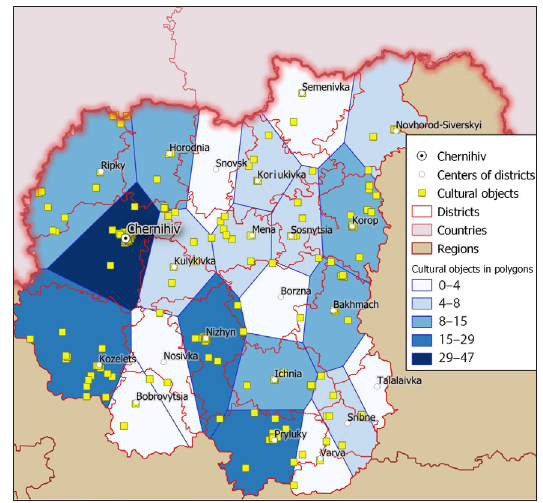
Figure 6. A Voronoi diagram of historical and cultural objects of Chernihiv region with loci around the centers of the districts